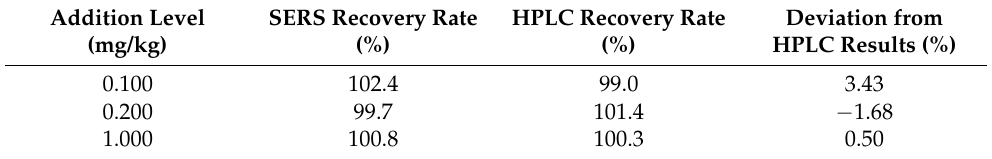
Table 4. Comparison of different SERS detection methods of BPA.